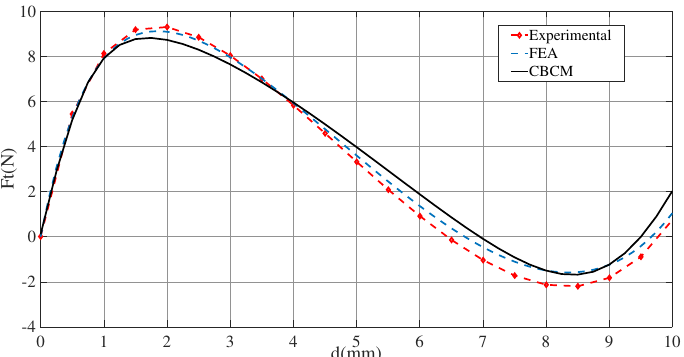
Figure 15. Bistable curves of CBBM.